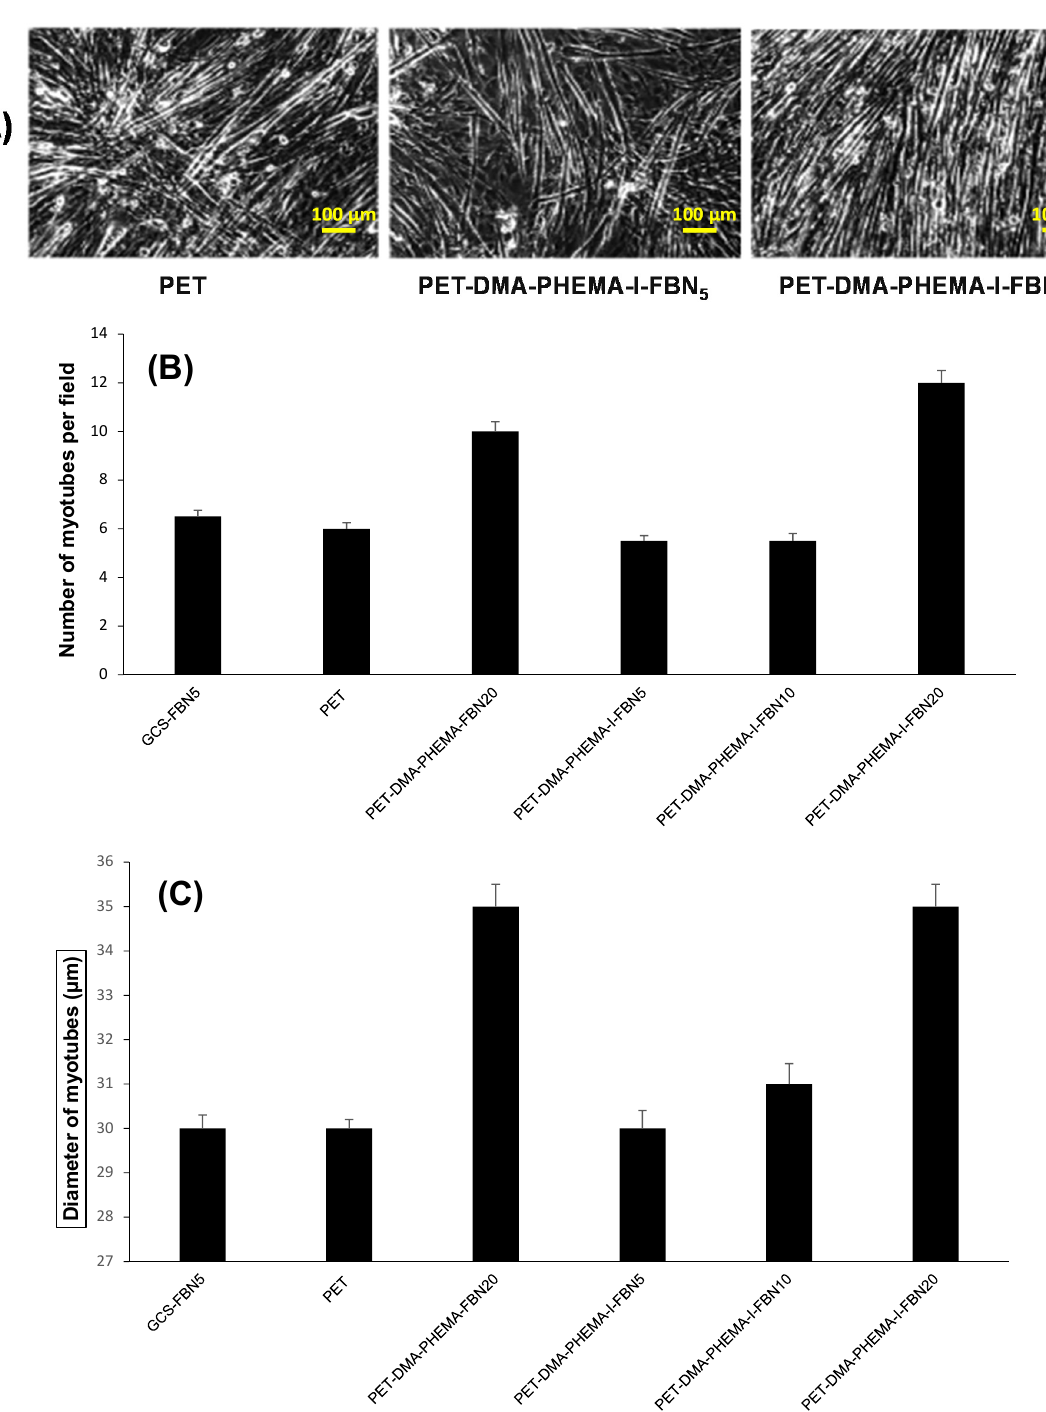
Figure 6. Cell differentiation on PET membranes. ( A ) Photomicrographs representative of cell differentiation on PET membranes. Photographs were taken at day 7 after plating, for PET, PET 5 FBN, and PET 20 FBN membranes. Fusiform long structures are differentiated myotubes resulting from the fusion of individual myoblasts. ( B ) Number of myotubes. C2C12 muscular cells were plated at day one at the same conditions as for Figure 4. They were left 7 days to grow and differen- tiate. At day 7 the medium was changed from growth medium to differentiation medium. Differentiation was character- ized by cell fusion into long multinucleated myotubes. At day 7, the number of myotubes on PET membranes was counted on 5 different fields. The mean value of the number of myotubes is shown on PET surfaces subjected to various treatments. ( C ) Diameter of myotubes. Photographs of the fields were taken and the diameter of myotubes measured. The average value is reported on the graph, depending on the various treatment of PET supports. Glass + FBN: glass coverslips coated